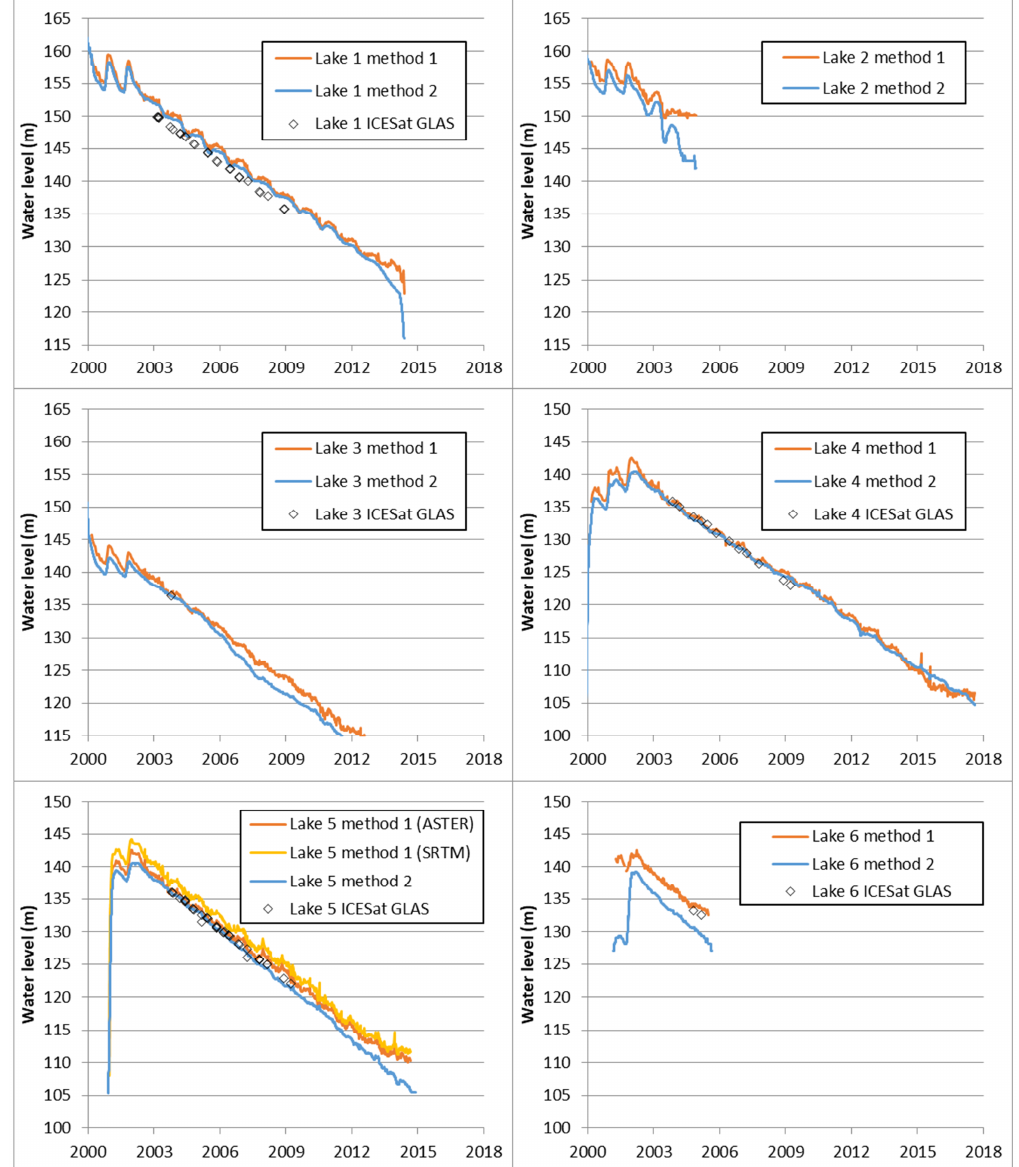
Figure 10. Comparison of methods for estimating water level (in colored lines) for all six lakes, with validation data from ICESat-1 GLAS laser altimetry (black diamonds). Table 5. Maximum average depth and date of maximum for each lake.